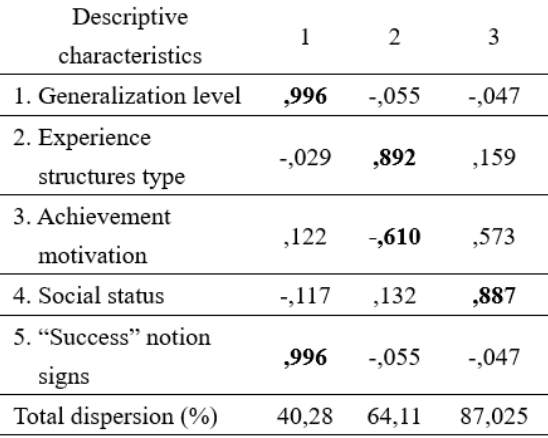
Table 2. Components of the success mental representations factor structures in group 2